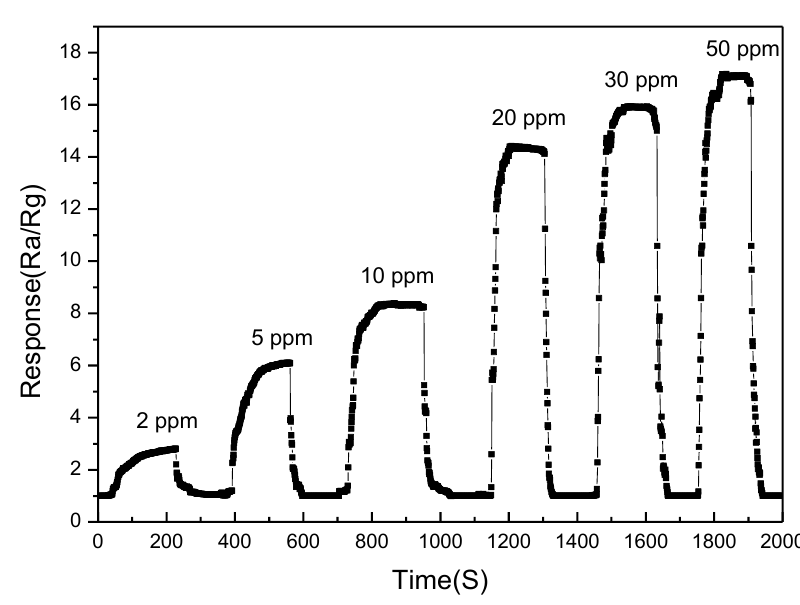
Figure 8. Transient response curves of the MFI-S coated SnO 2 gas sensors to formaldehyde.